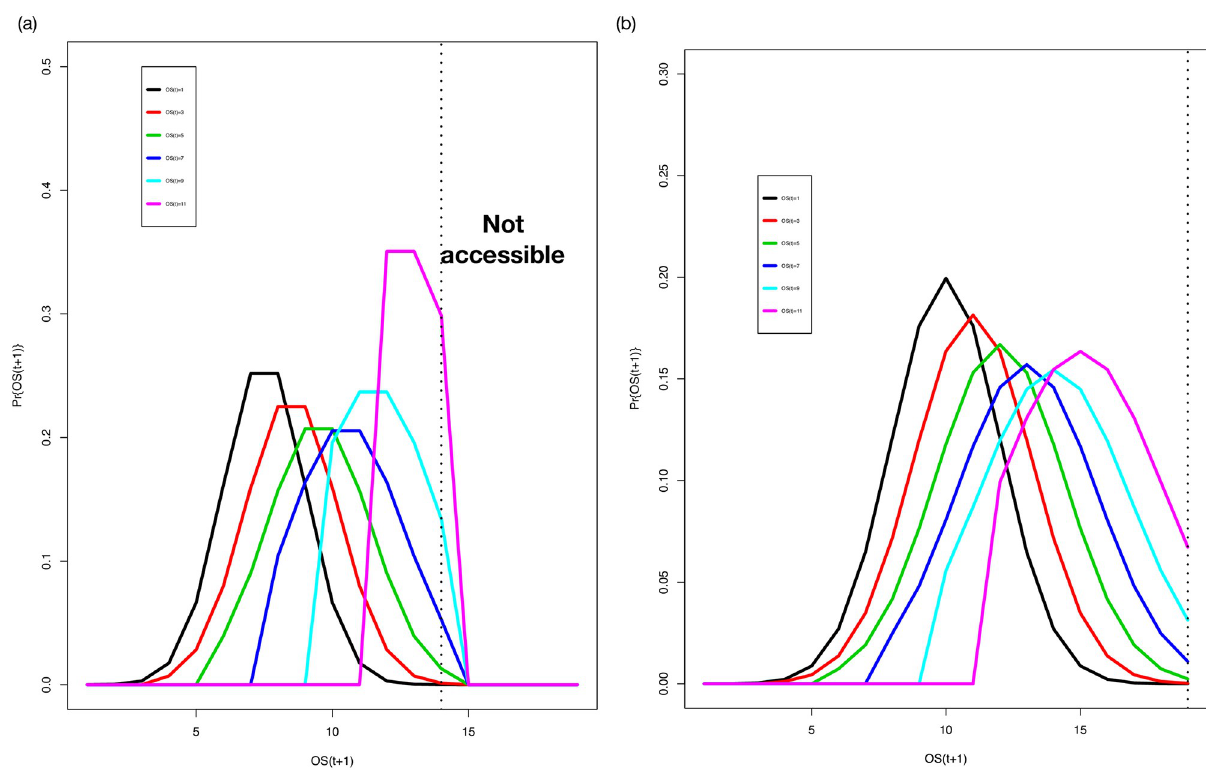
Fig 4. The updating distribution f ( OS ( t ), OS ( t + 1), t ) for t = 190 (left panel) or 290 (right panel) and six choices of OS ( t ): 1 (black), 3 (red), 5 (green), 7 (dark blue), 9 (light blue), and 11 (pink). The dotted lines show regions that are not accessible for updating at that time (determined by the trajectory of the most recent OS, as in Fig 2D). For example since K (190) = 15, at time t = 190 any OS update beyond 15 corresponds to a time in the future.